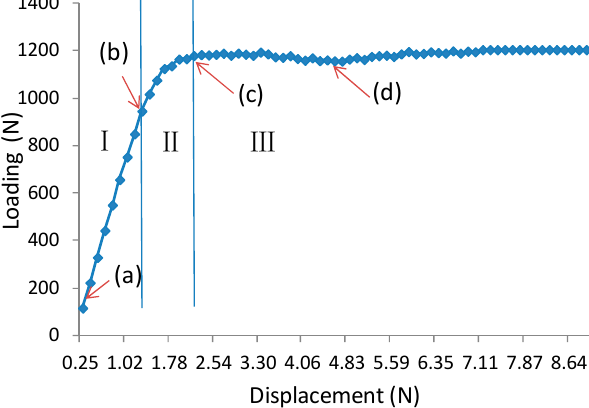
Figure 3. Typical load-displacement curve of core shear failure of wooden sandwich beam with Taiji honeycomb core (A3B2C2): ( a ): Unloaded; ( b ) buckling of inclined cell wall; ( c ) buckling of whole cell wall; ( d ) post-buckling stage. Table 3. Experimental parameter combinations of sandwich beam structures.